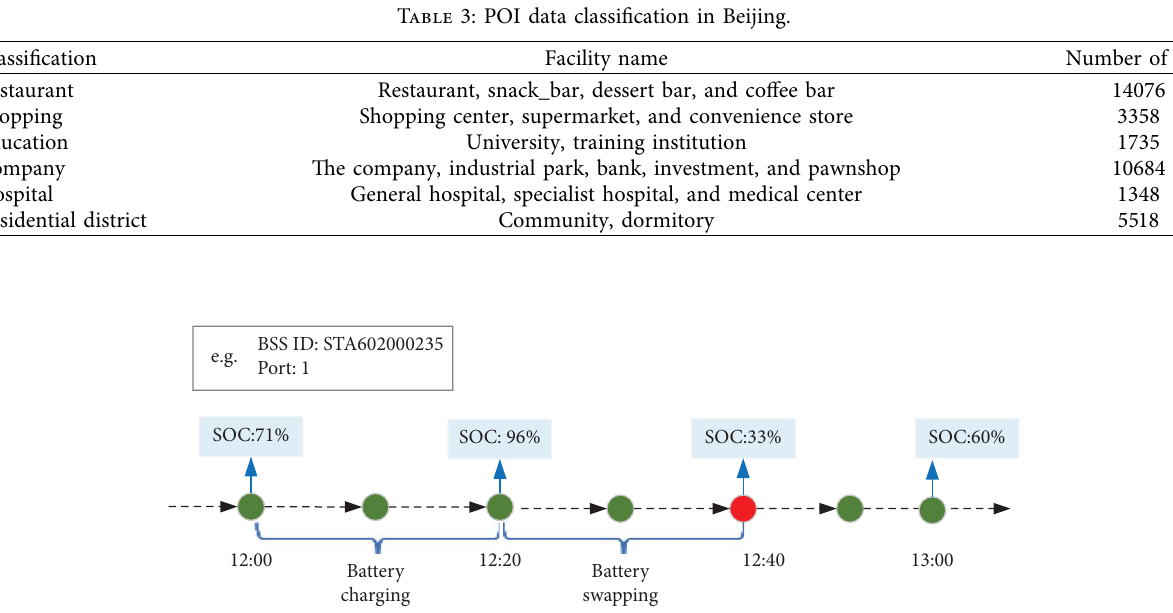
Figure 6: Illustration of battery swapping